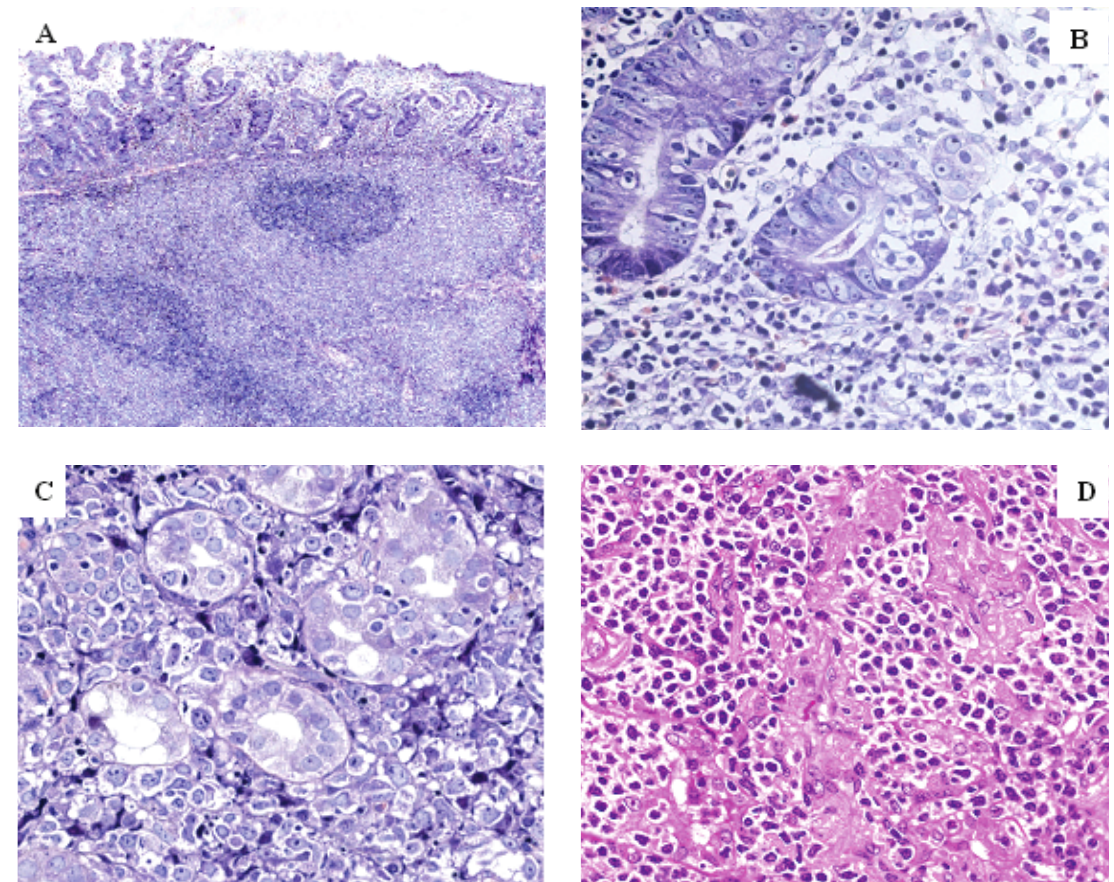
Figure 1: Representative micrographs of (mucosa associated lymphoid tissue (MALT) lymphomas. A) Low grade gastric MALT lymphoma (overview of a surgical specimen), B) low grade gastric MALT lymphoma with lymphoepithelial lesions C) high-grade blastoid gastric MALT lymphoma, and D) low grade pulmonary MALT